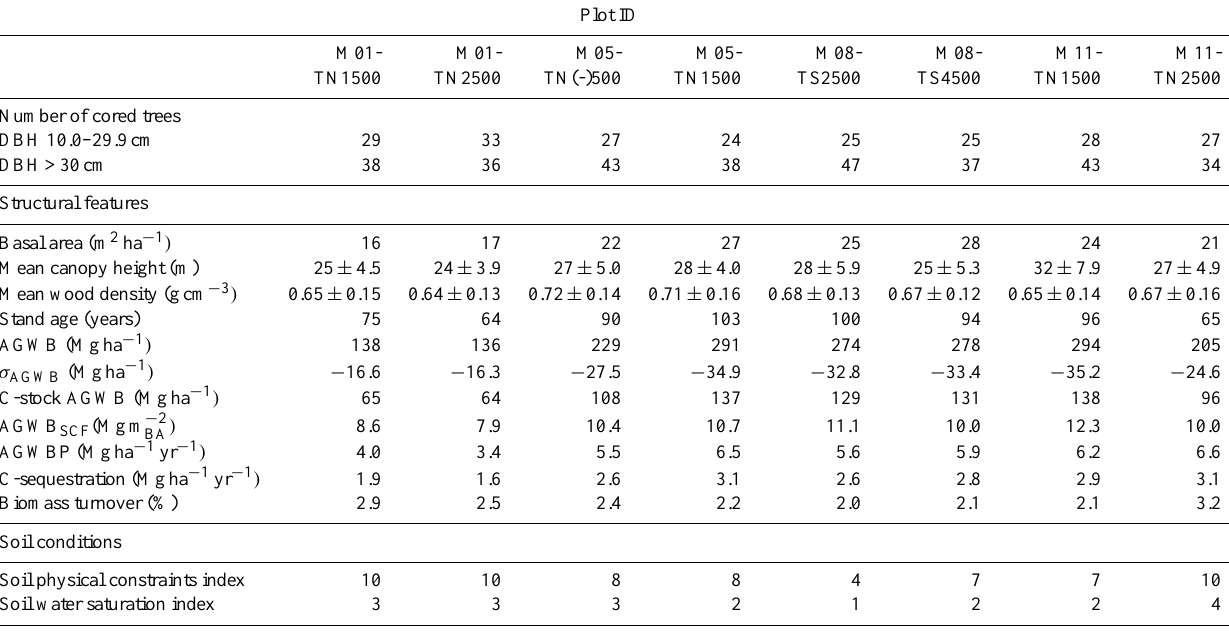
Table 3. Number of sampled trees from the diameter classes 10.0–29.9cm and >30cm in each plot. Stand structure is described by basal area as well as by means and standard deviation of canopy height and wood density. Estimates of AGWB and C-stocks in AGWB and the structural conversion factor (AGWB SCF related to m 2 basal area); σ AGWB indicates the error of the AGWB estimate. Furthermore for each plot, information on aboveground coarse wood productivity (AGWBP) and carbon sequestration per hectare and year (C-sequestration) are indicated, as well as the annual biomass turnover. The soil conditions are indicated by the soil physical constraints and the soil water saturation indices (see Table 2 for scoring).